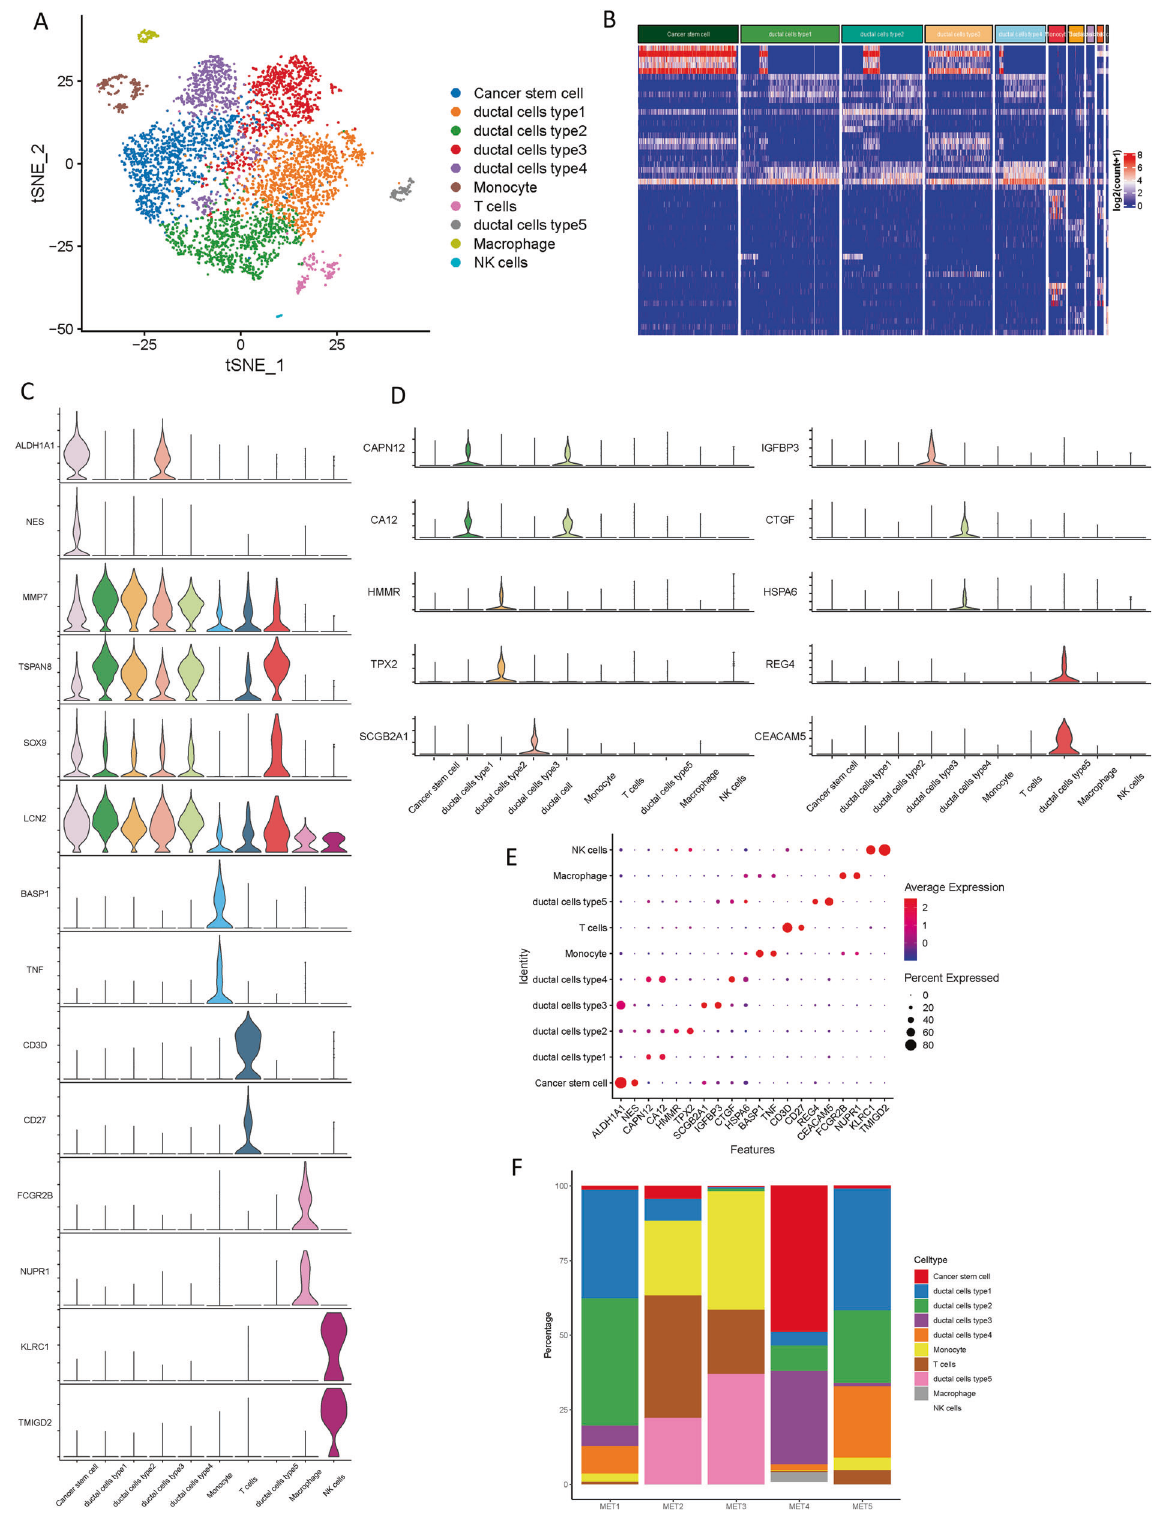
Fig. 1 Single-cell transcriptomic analysis of metastatic PDAC lesions. A The t-distributed stochastic neighbor embedding (t-SNE) plot of the 10 identi fi ed main cell types in metastatic PDAC lesions. B Heatmap of top 5 DEGs among the myeloid cell subtypes, where the colors from red to blue represented alterations from high expression to low expression. C Violin plots showing the normalized expression levels of 14 representative canonical marker genes across the 10 clusters. D Violin plots showing the expression level of representative novel identi fi ed markers across the main cell types. E Dot plots showing the 20 signature gene expressions across the 10 cellular clusters. The size of dots represents the proportion of cells expressing the particular marker, and the spectrum of color indicates the mean expression levels of the markers (log1p transformed). F Relative proportion of each cell cluster across 5 metastatic PDAC lesions as indicated.